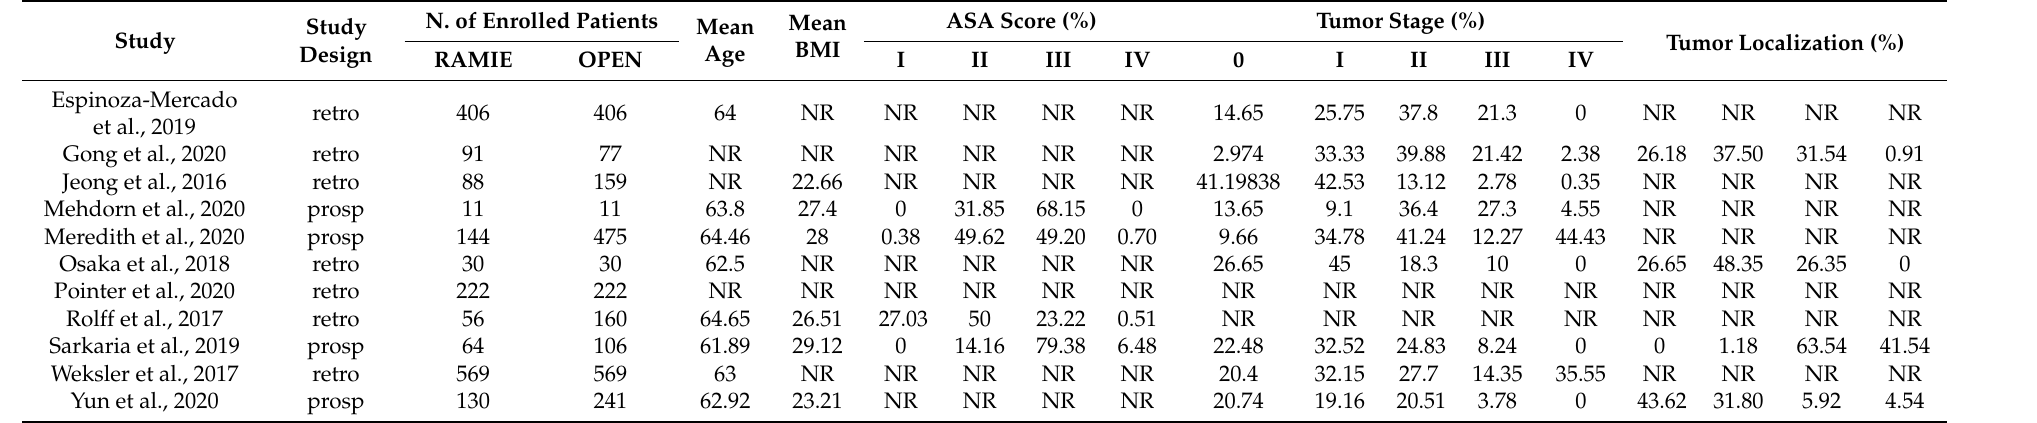
Table 2. Characteristics of the included studies comparing robotic and open